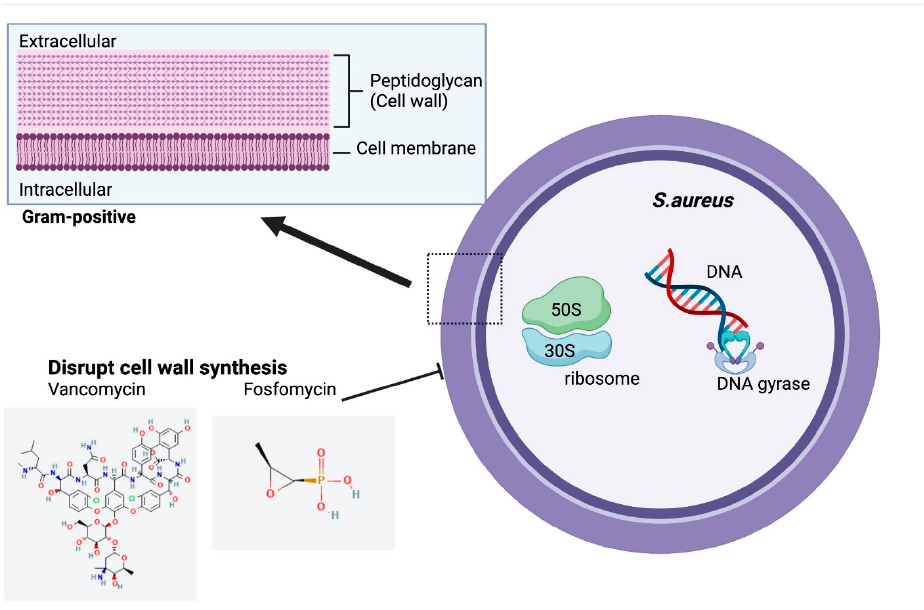
Figure 5. Structure and Mechanism of Action of Inhaled Antibiotics Targeting Chronic S.aurues In- fection in CF. Chemical structures accessed from PubChem [104,105].